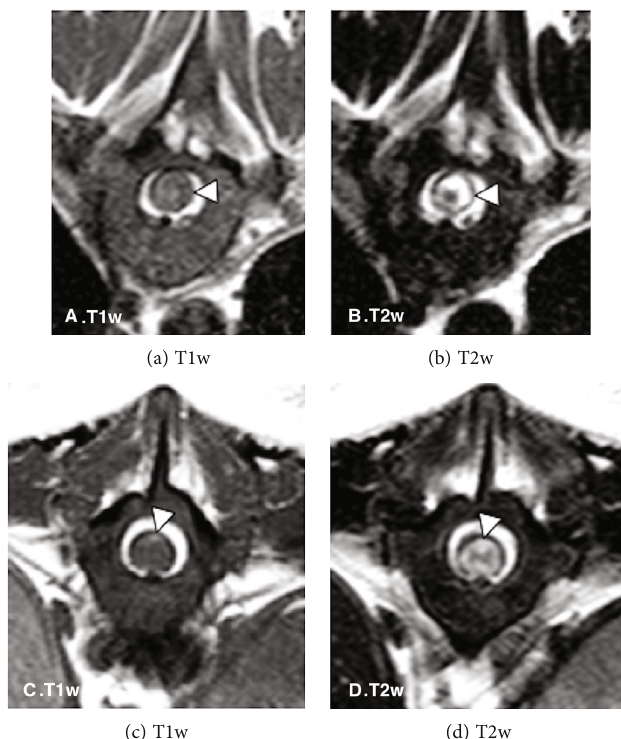
Figure 2: MRI transverse planes at T8 level (a, b). The images show an intramedullary lesion which is hyper- to isointense with and hypointense rim on T1-weighted images (a) and hypointense with a hyperintense rim on T2-weighted images (b). This pattern is suggestive of early subacute haematoma surrounded by fl uid. At T12 level (c, d), the images show an intramedullary lesion which is mildly hyperintense on T1-weighted images (c) and hyperintense on T2 (d). These fi ndings are suggestive of late subacute haematoma.